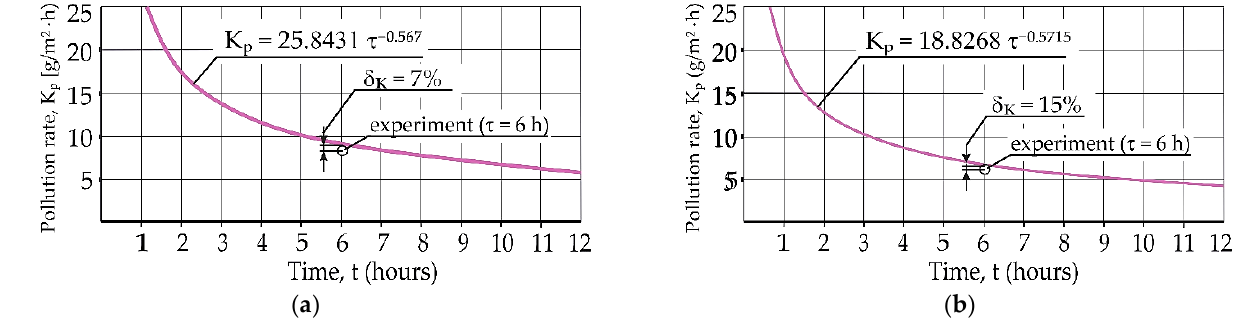
Figure 4. Dependences of the pollution rate K p from time of experiments τ during fuel oil (S r = 1.5%, α = 2.9, and W r = 2%) ( a ) and WFE (S r = 1.5%, α = 2.9, and W r = 30%) ( b ) combustion.